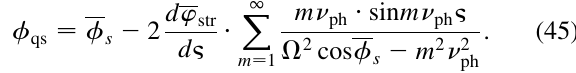
FIG. 5. (Color) Dependence of first (red line), second (blue line), and third (black line) derivatives versus normalized